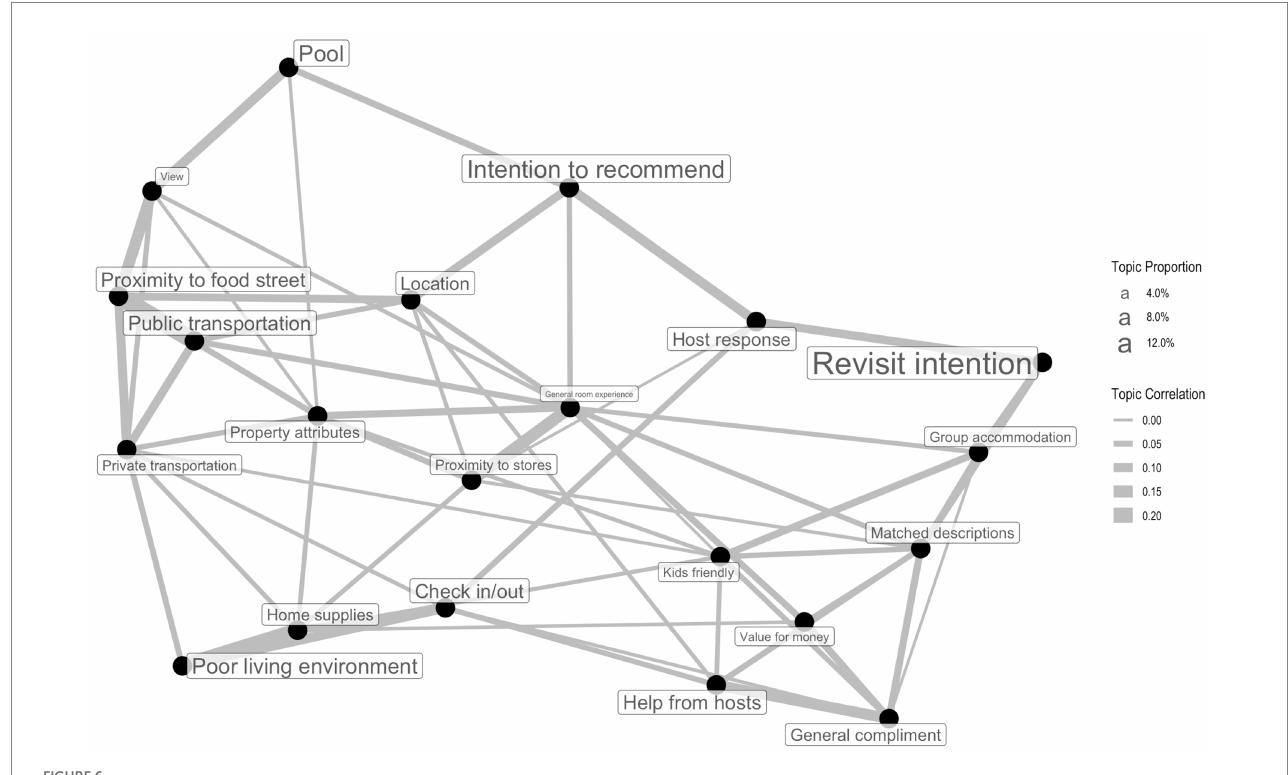
FIGURE 6 Topic correlation map.